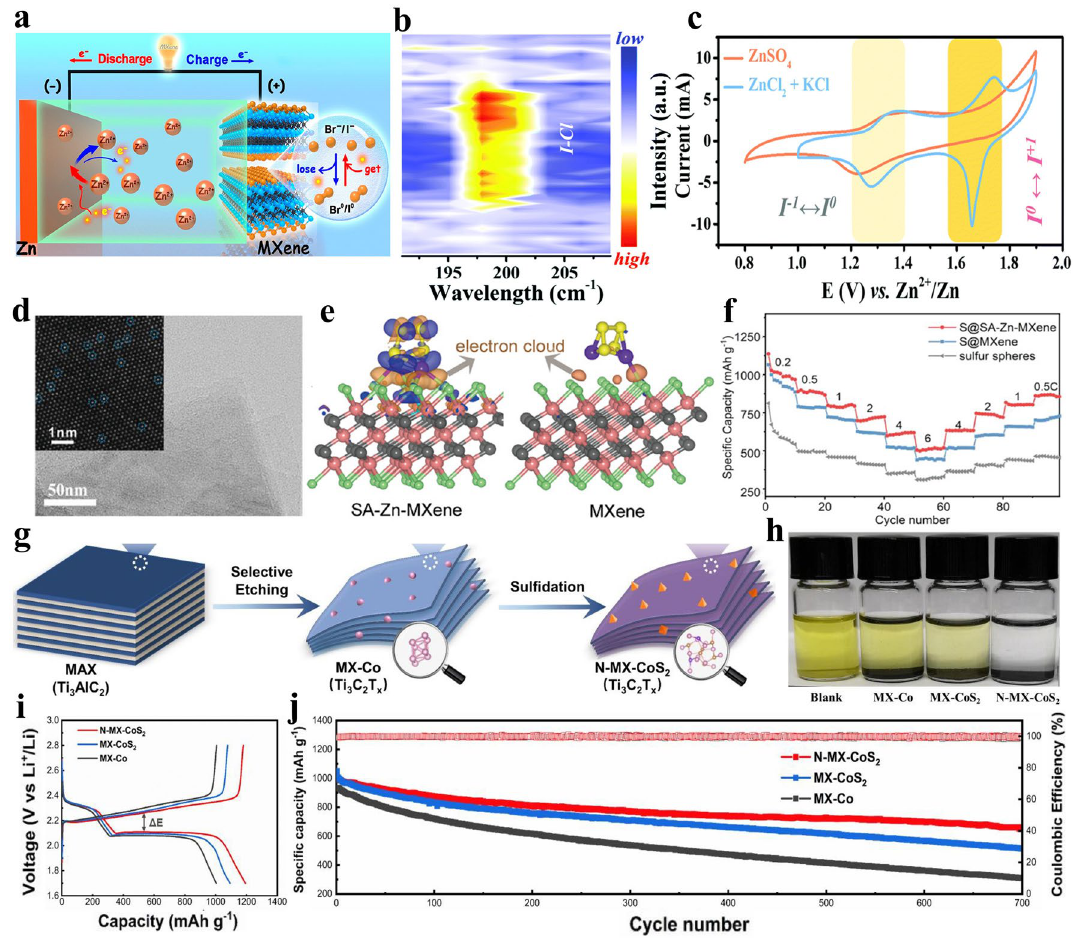
Fig. 12 a Schematic diagram of the working mechanism of Zn/halogenated Ti 3 C 2 MXene cells. Reproduced with permission from [123] Copy- right 2021, American Chemical Society. b In-situ Raman spectra of the Ti 3 C 2 I 2 cathode around 200 cm −1 . c CV curves of Ti 3 C 2 I 2 cathode in ZnCl 2 + KCl electrolyte or conventional ZnSO 4 electrolyte. Reproduced with permission from [194] Copyright 2021, Royal Society of Chem- istry. d HAADF-STEM image of SA-Zn-MXene. e Charge density difference for Li 2 S 4 polysulfides adsorbed on SA-Zn-MXene and MXene. f Rate capabilities of S, S@MXene and S@SA-Zn-MXene. Reproduced with permission from [157] Copyright 2020, Wiley–VCH. g Schematic of the preparation process of N-MX-CoS 2 hybrids. h Adsorption test of MX-Co, MX-CoS 2 and N-MX-CoS 2 . i Galvanostatic charge–discharge curves of Li–S batteries with various materials-modified separator at 0.2C. j Long-term cyclic stability of Li–S batteries with various materials- treated separators at 1 C. Reproduced with permission from [146] Copyright 2021,